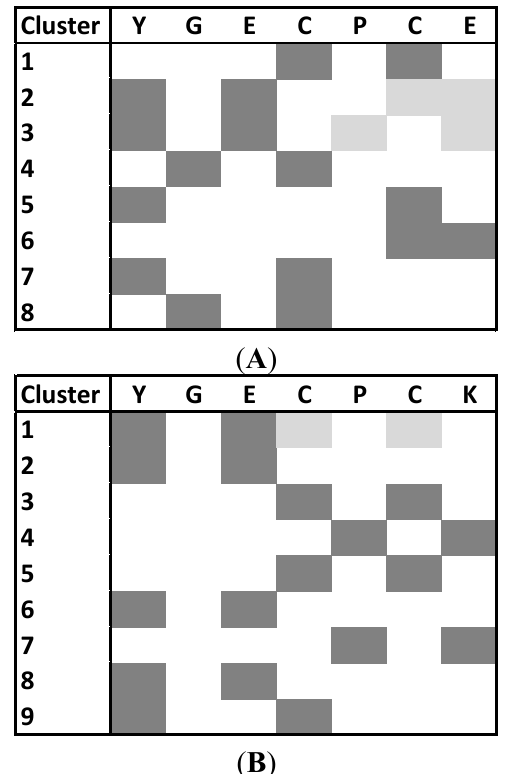
Figure 5. The map of MM H-bonds in the 8 and 9 clusters calculated for the PepE ( A ) and PepK ( B ), respectively, during MD simulations. We reported with the same colors the residues involved in the same MM